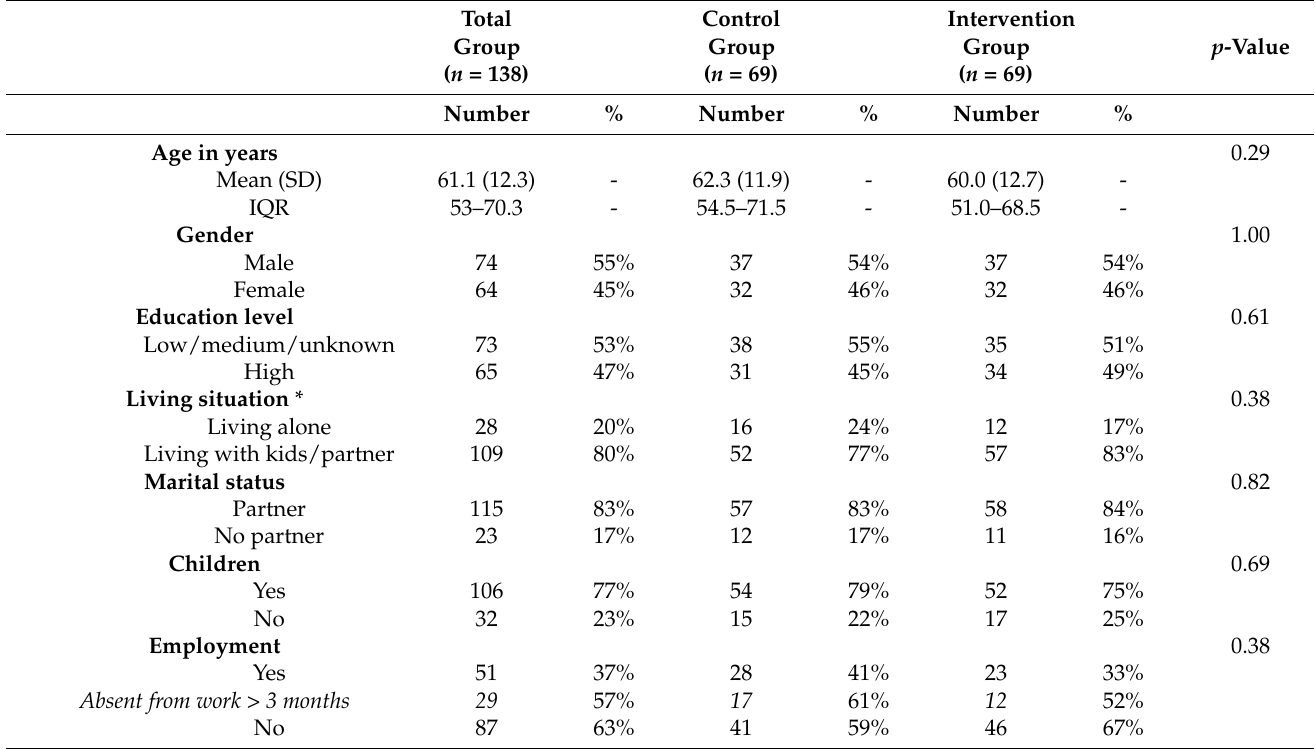
Table 1. Patients’ sociodemographic and clinical characteristics at